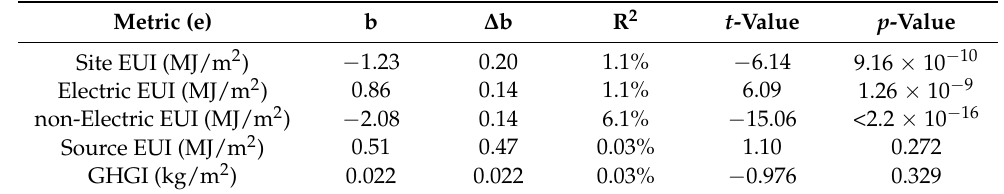
Table 5. Results of linear regressions of five intensity metrics (e) on the year built for non-LEED offices.